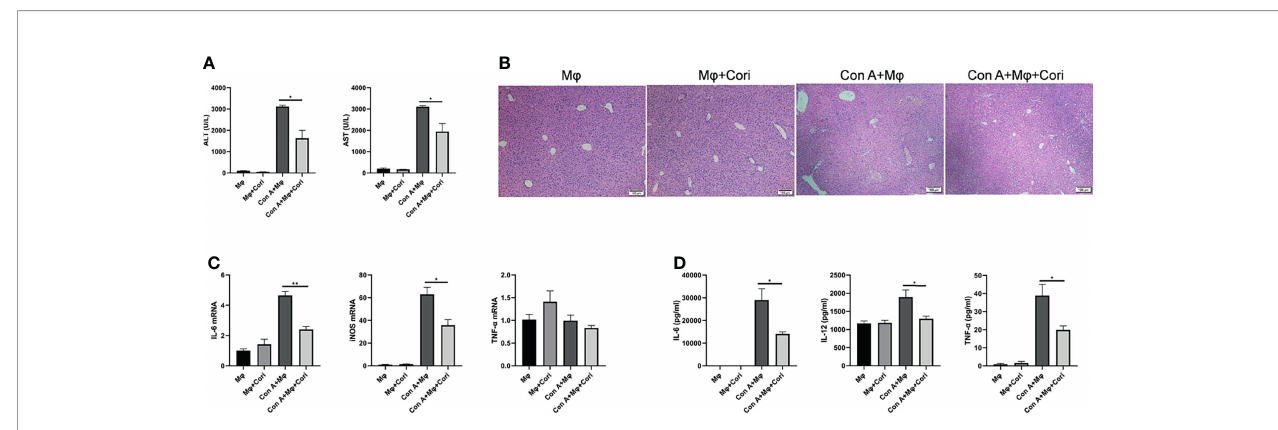
FIGURE 4 | Corilagin treated macrophage protects against Con A-induced liver injury in an adoptive transfer experiment. Macrophage cultured in vitro were treated with corilagin (10 m g/ml); 3 h later these cells were collected and injected into mice intraperitoneally. After 12 h, mice were challenged with Con A (20 mg/kg body weight). Liver tissues were collected 12 h later. (A) Serum ALT and AST levels; (B) H&E staining of liver tissues. Original magni fi cation, 100×. (C) IL-6, iNOS, and TNF- a expression in the liver detected by qRT-PCR. (D) IL-6, IL-12, TNF- a levels in serum detected by ELISA. *p < 0.05, **p < 0.01.